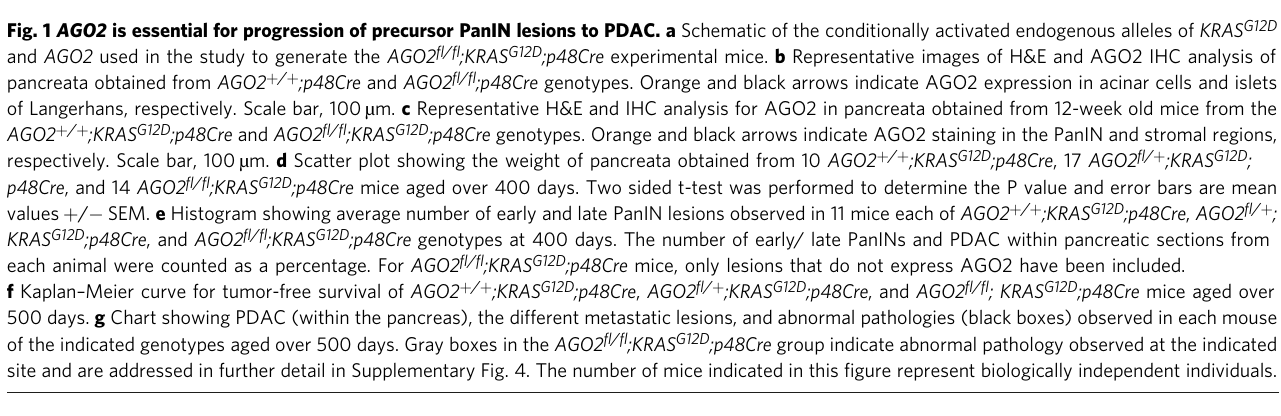
Fig. 2a – b, PanINs of AGO2 fl / fl ;KRAS G12D ; p48Cre mice showed a